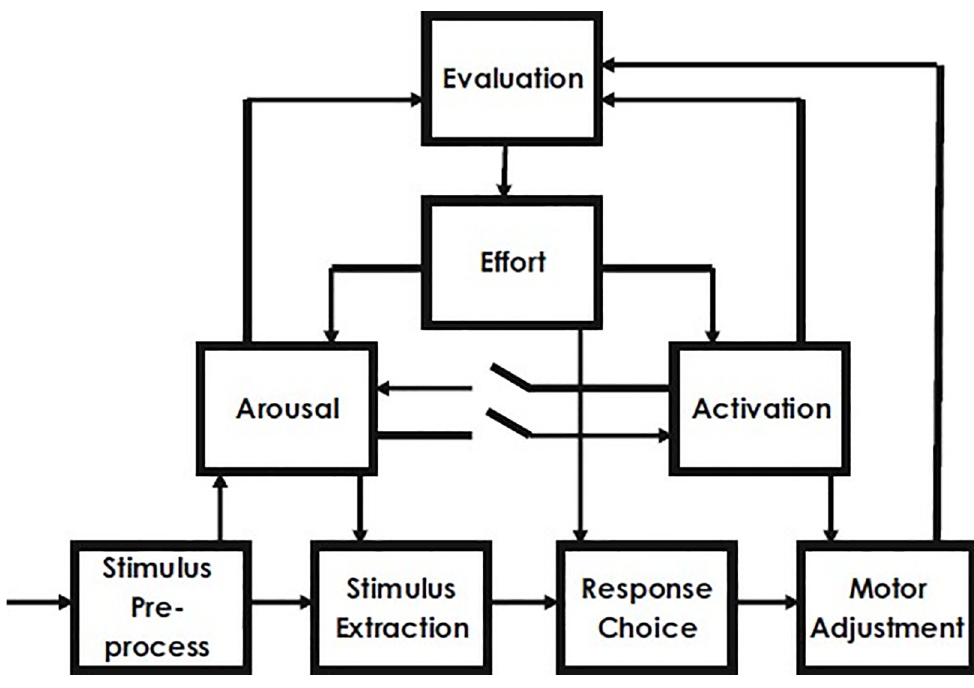
Fig 1. The cognitive energetic model of Sanders